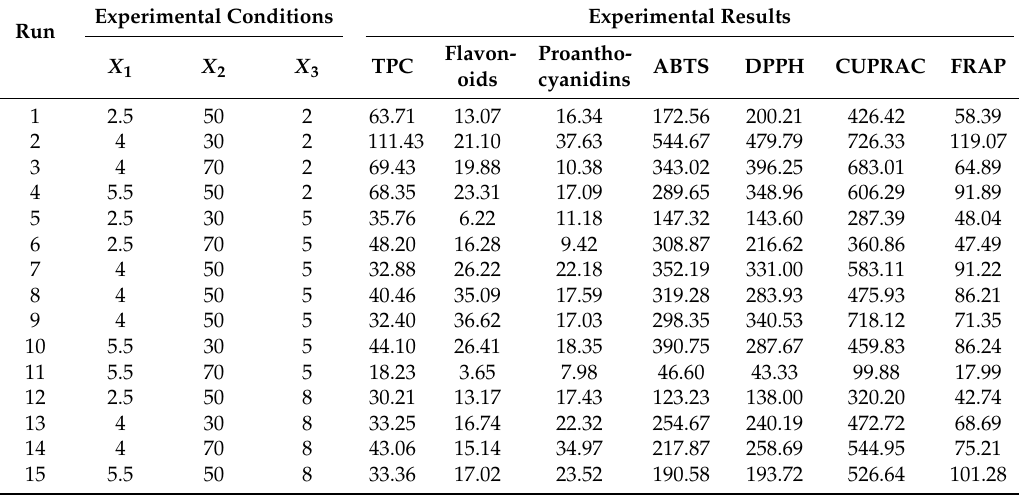
Table 1. Box-Behnken design and the observed